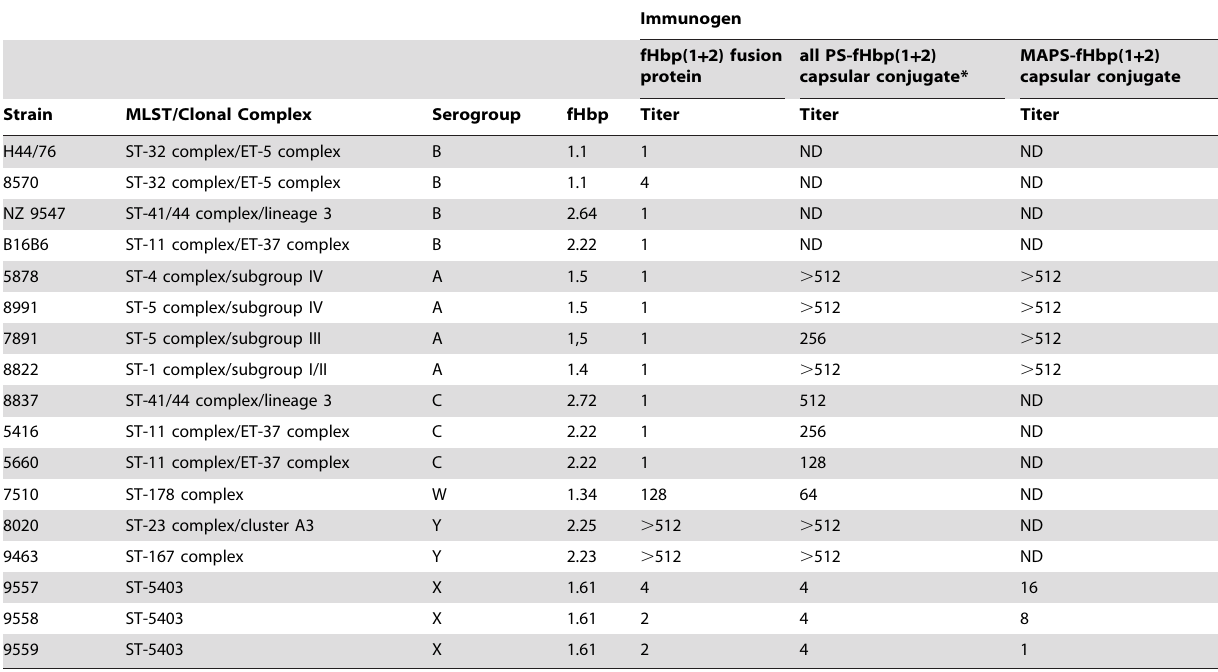
Table 3. Bactericidal activity induced by PS-fHbp(1 + 2) conjugates.